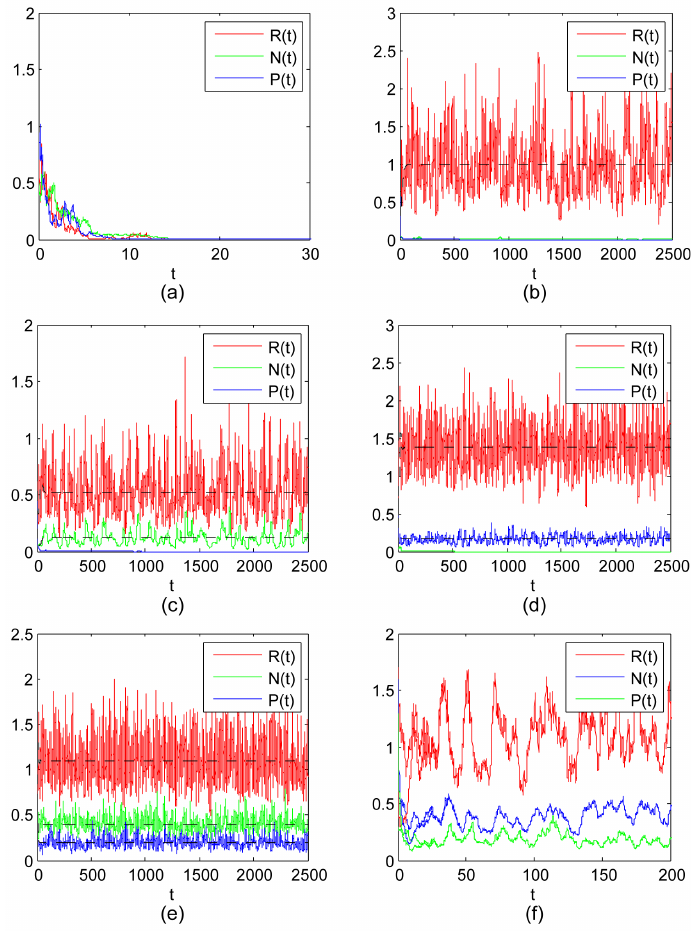
Figure 1. ( a ) α r = 0.9177, α n = 0.4472, α p = 0.6325, 0.8 = 2r < α 2 r = 0.8422; ( b ) α r = 0.7750, α n =